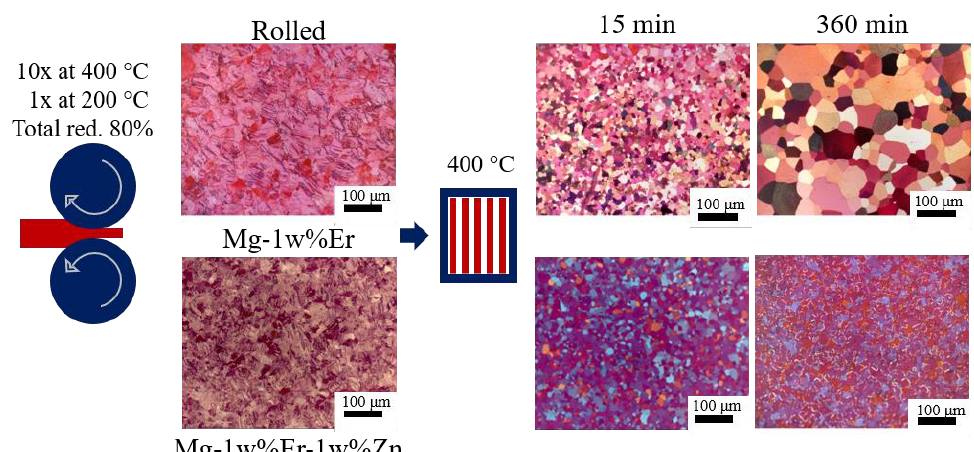
Figure 2. Micrographs of Mg-1%Er and Mg-1%Er-1%Zn in the as-rolled state and upon annealing at 400 °C for 15 and 360 min. The images are taken from the rolling plane (mid-thickness).